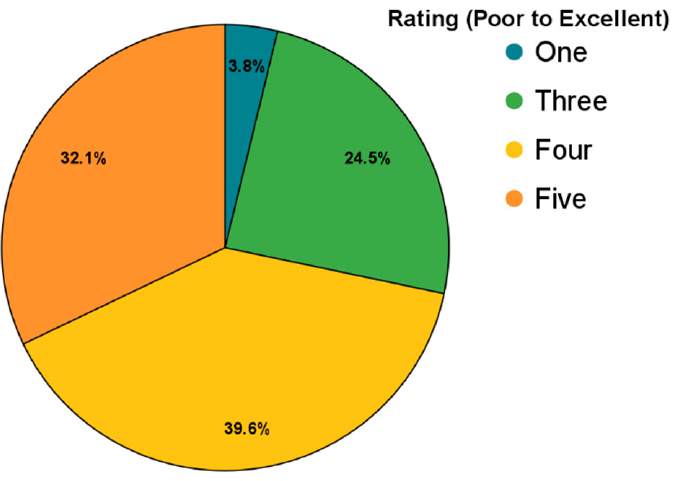
Figure 15. Rating of the Anat_Hub mobile application on a scale of 1 to 5 (poor to excellent).